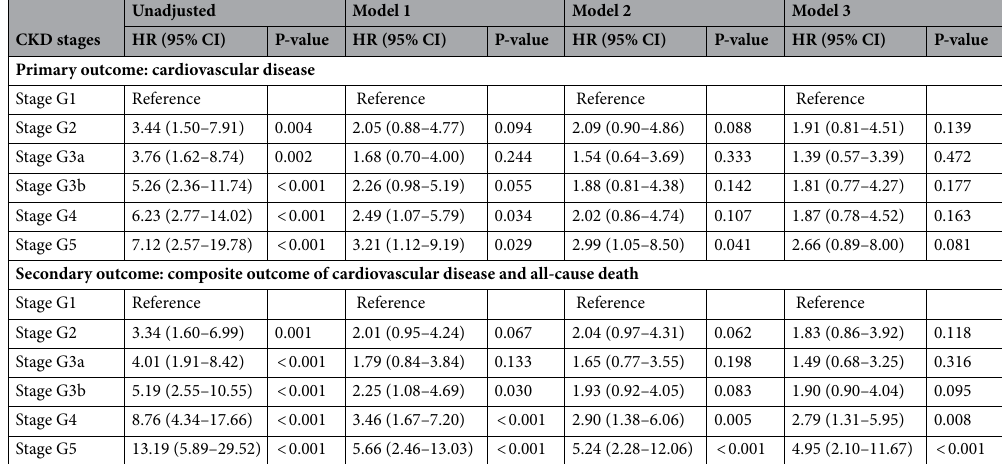
Table 3. Cause-specific hazard model for the multivariate regression analysis of outcomes according to CKD stages after adjustment with confounding factors (CKD stage G1 as reference). Model 1: adjusted for age and sex. Model 2: adjusted for variables in model 1, in addition to prevalence of diabetes, and prevalence of cardiovascular disease. Model 3: adjusted for variables in model 2, in addition to diastolic blood pressure, total cholesterol, HDL cholesterol, and high-sensitivity C-reactive protein. CI confidential interval, CKD chronic kidney disease, HR hazard ratio.